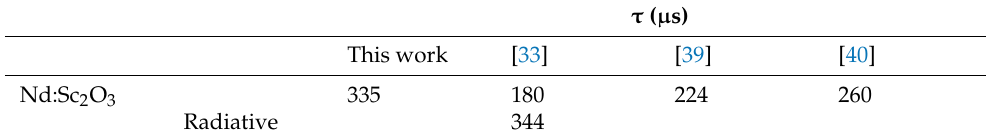
Table 9. Decay time of 1%Nd:Sc 2 O 3 .